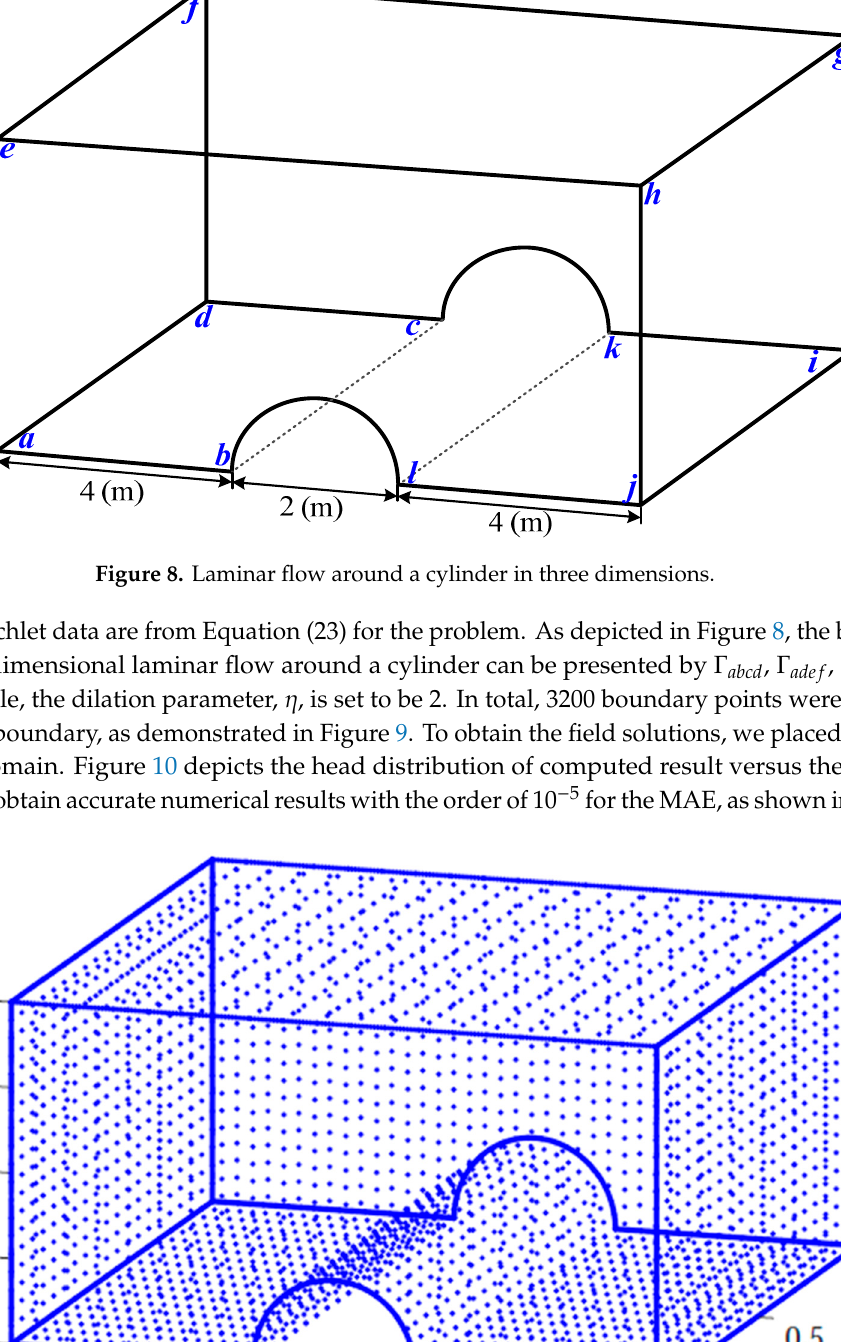
Figure 9. Collocation points on the three-dimensional boundary.